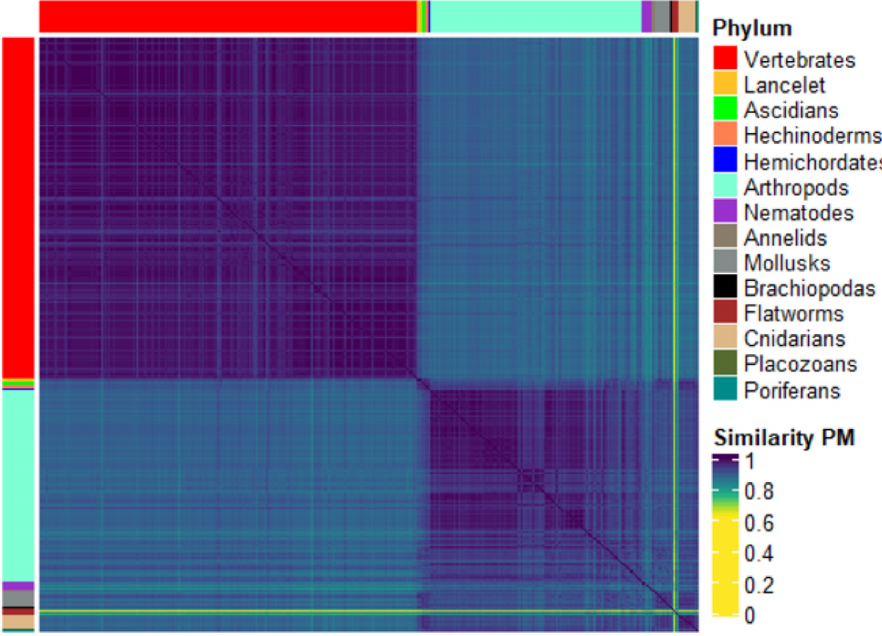
Fig 4. Heatmap of the PM similarity matrix of all KEGG Animals (left) and composition of clusters w.r.t. a total of four clusters for the PM graph kernel.